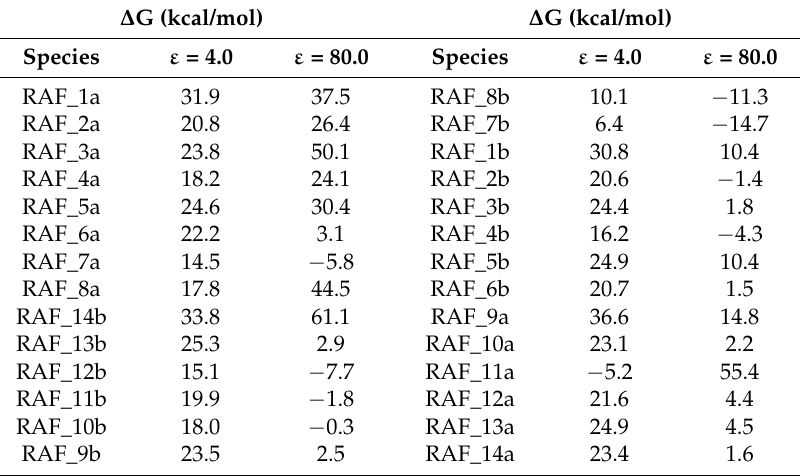
Figure 4. B3LYP/6-311++G** optimized structures of transition states intercepted studying HAT mechanism from Vam3 to · OOH free radical. Imaginary frequencies (cm − 1 ) and most significant geometrical parameters (Å) are also reported. Table 3. Gibbs free energy values for radical adduct formations between Vam3 and · OOH free radical at 298.15 K.